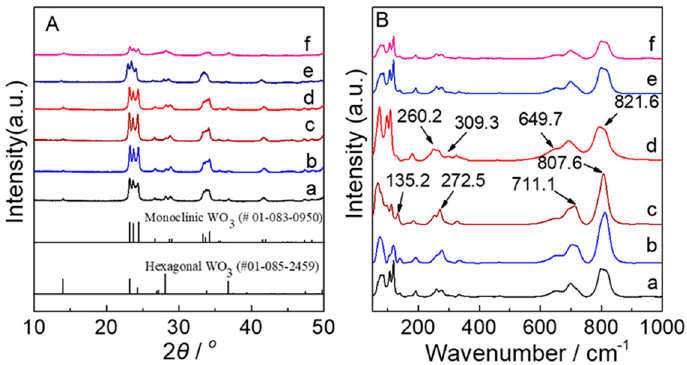
Figure 1. ( A ) XRD patterns and ( B ) Raman spectra of (a) WO 3 − 0, (b) WO 3 − 5, (c) WO 3 − 10, (d) WO 3 − 15, (e) WO 3 − 20, and (f) WO 3 − 25. clinic WO 3 at 135.2 cm − 1 (lattice vibration), 272.5 cm − 1 ( δ (O-W-O) deformation